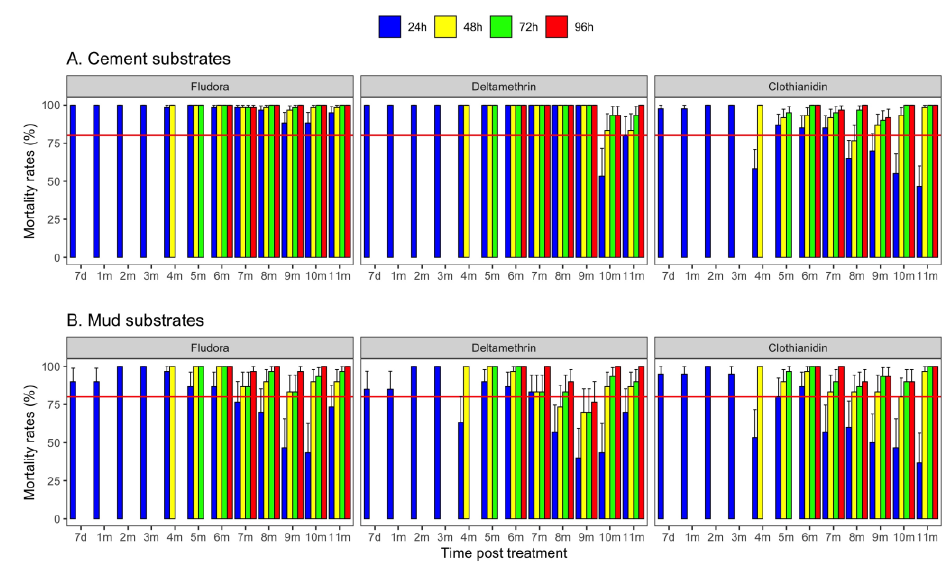
Table 1. Mortality rates of the laboratory and wild colonies to 0.05% deltamethrin. Colonies Tested Alive